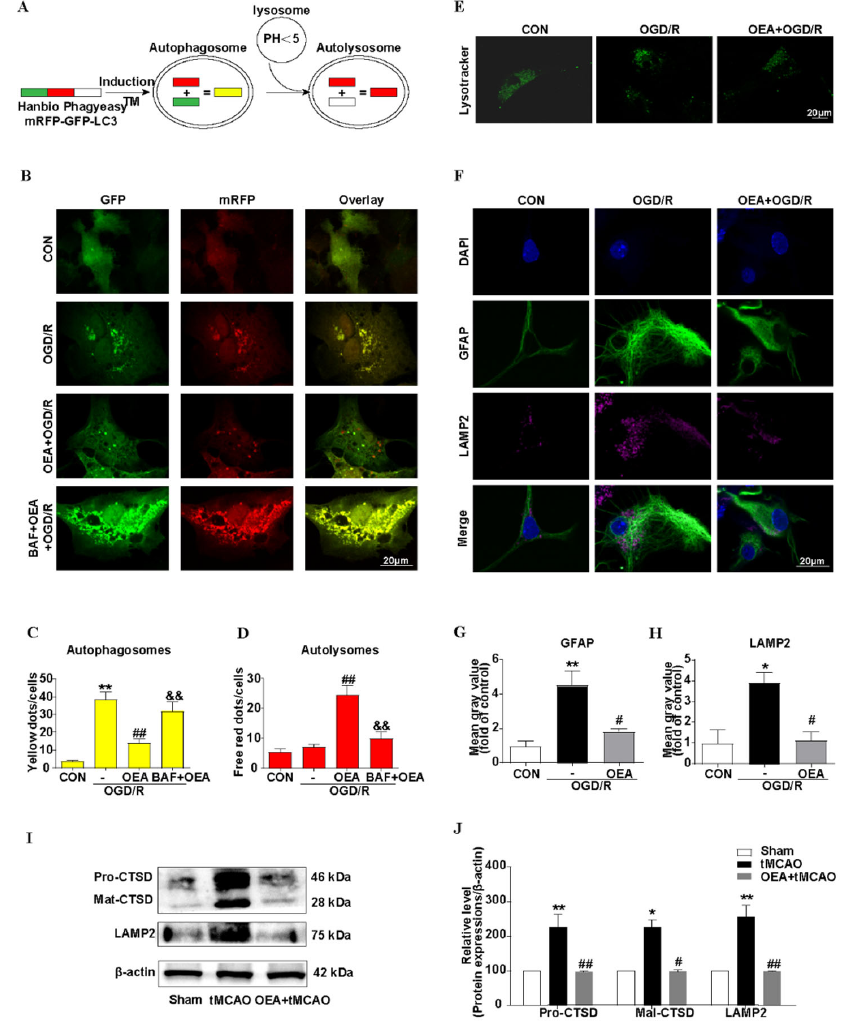
Figure 5. OEA restores autophagic flux by preserving the lysosome function in astrocytes after brain ischemia in vitro and in vivo. ( A ) The schematic diagram of the mRFP-GFP-LC3 plasmid. The primary astrocytes were incubated with mRFP-GFP-LC3 adenoviral particles for 2 h. Then, they were exposed to OGD/R, with or without drug treatment, for another 36 h at 37 ◦ C. ( B ) The representative images of the immunofluorescent astrocytes expressing mRFP-GFP-LC3. Green fluorescence repre- sents GFP, and red fluorescence represents mRFP. ( C , D ) The statistics of autophagosomes (yellow dots) and autolysosomes (free-red dots) in each group. The fluorescent punctas were determined by manual counting from at least four randomly selected images with a 60 × oil immersion objective per coverslip. At least 40 cells were randomly selected for counting in each group. The OEA (50 µ M) was pretreated for 12 h before exposure to OGD/R. The BAF (500 nM) was pretreated 1 h before OGD/R. Data are representative of the three independent experiments and are expressed as the mean ± SEM. ** p < 0.01 vs. normal control; ## p < 0.01 vs. OGD/R control; && p < 0.01 vs. OGD/R+OEA group. ( E ) The representative images showing Lysotracker (Green) staining in primary-cultured astrocytes; ( F – H ) The fluorescent immunostaining and quantification of GFAP and LAMP2 in primary-cultured astrocytes (GFAP: green; LAMP2: purple; and Hoechst: blue). Data are representative of the three independent experiments and are expressed as the mean ± SEM. * p < 0.05, ** p < 0.01 vs. normal control; # p < 0.05 vs. OGD/R control; OGD/R represented OGD for 6 h and reoxygenation for 24 h. ( I , J ) The immunoblotting analysis and quantification of LAMP2 and CTSD in brain tissues 14 d after tMCAO in mice with vehicle or OEA pre-treatment. Data are expressed as the mean ± SEM; n = 3; * p < 0.05, ** p < 0.01 vs. sham group; # p < 0.05, ## p < 0.01, vs. vehicle-treated tMCAO